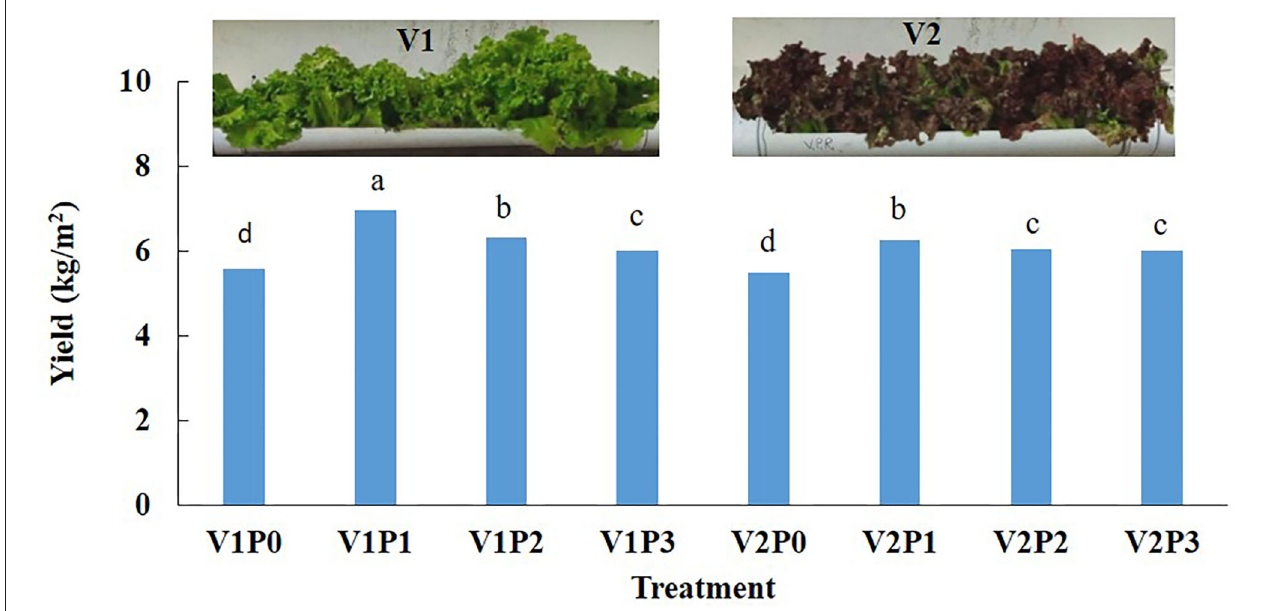
FIGURE 2 | Yield of lettuce cultivars ( Lactuca sativa cv. Green Wave, V1; Lactuca sativa cv. New Red Fire, V2) grown in different organic growing media (P0: control, 100% soil; P1: 40% soil + 40% vermicompost + 20% cocodust; P2: 50% soil + 50% vermicompost; P3: 20% soil + 40% vermicompost + 40% spent mushroom compost). The mean values with different letters are significantly different based on Duncan’s Multiple rage Test (DMRT) at P <